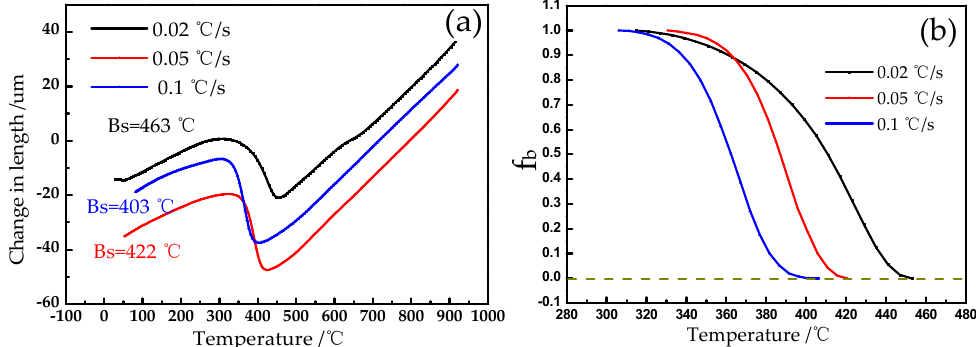
Figure 11. ( a ) The cooling curves of the matrix, and ( b ) the relationship between bainite transformed volume fraction and temperature at 0.02 °C/s, 0.05 °C/s and 0.1 °C/s cooling rate.